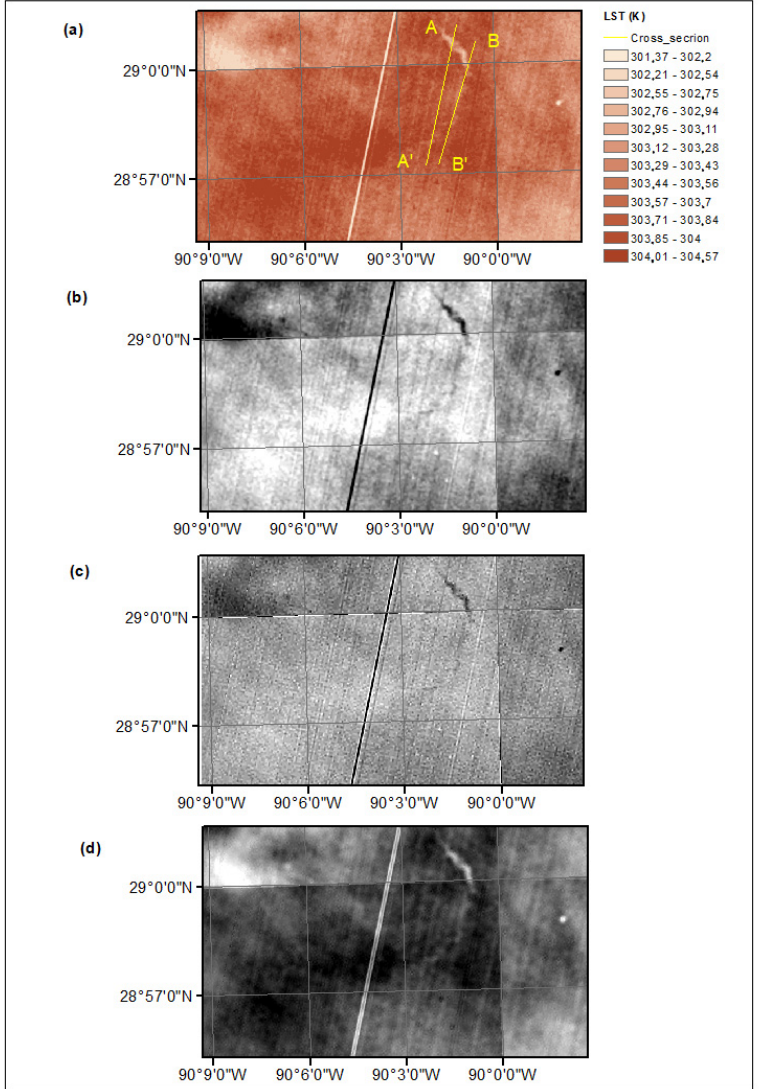
Figure 11. ( a ) The LST from Landsat 8 thermal band 10 on 3 September 2021, ( b ) Mean filter of LST with 3 × 3 Kernel, ( c ) A High-Pass filter of LST with 3 × 3 Kernel, ( d ) A High-Pass filter of LST with 5 × 5